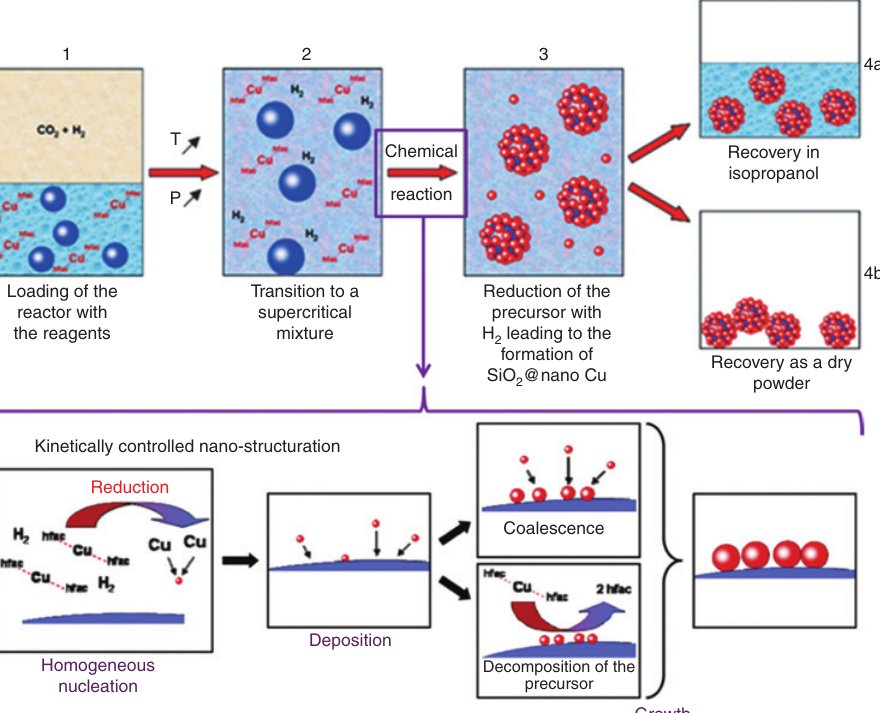
Figure 9: Sketch of the kinetically SFCD controlled surface nanostructuration process. Reprinted with permission from Marre S, Cansell F, Aymonier C, Nanotechnology 2006, 17, 4594–4599 [32], Copyright 2006 IOP